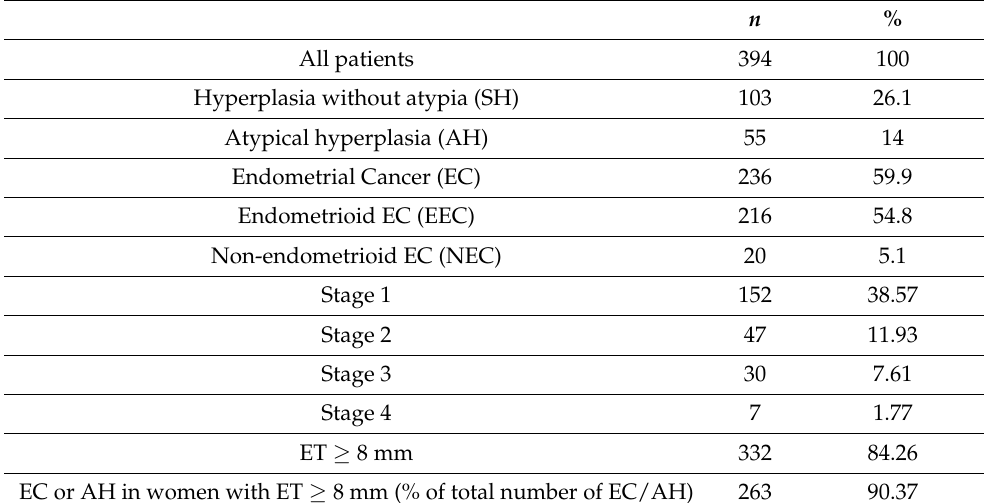
Table 2. Selected features of studied women with the specific histological diagnosis (endometrial thickness—ET, endometrial cancer—EC, endometrial hyperplasia without atypia—SH, atypical endometrial